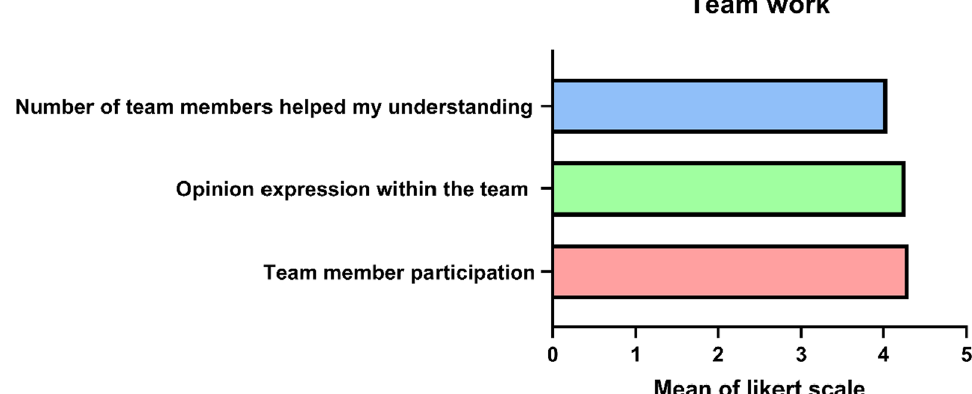
SD. n 116, where 1 is the least and 5 is the most ± =